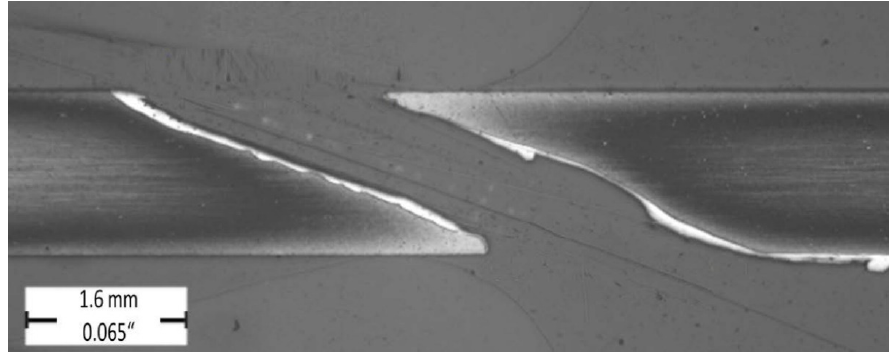
Figure 6. Longitudinal hole section (magnification 20x); sample group—1C (Table 2).